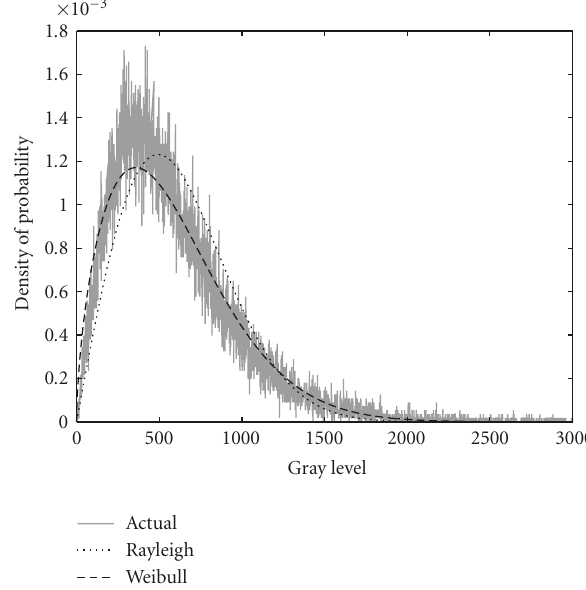
Figure 2: Comparison of two statistical models (Rayleigh and Weibull) with actual data: example of the image (Figure